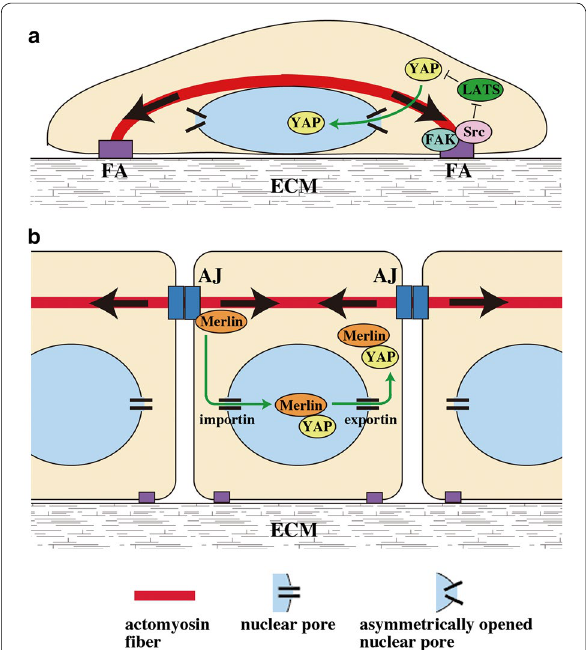
Fig. 4 Hypothetical models for actomyosin-dependent regulation of YAP nuclear localization in sparse and confluent cells. a Sparse cells develop FAs that are connected to actomyosin stress fibers. Tensile force exertion from stress fibers to FAs activates the FAK–Src signal, which inhibits LATS1/2-mediated phosphorylation of YAP, thereby facilitating nuclear translocation of YAP. In addition, contraction of stress fibers connecting FAs and the apical surface of the nucleus (sometimes called ‘actin cap’) flattens the nucleus, increases the curvature of the lateral part of the nuclear membrane, and thereby enlarges the diameter of the cytoplasmic side of the nuclear pore in this nuclear membrane part. Such ‘asymmetric opening’ of nuclear pores may preferentially promote nuclear import, rather than export, of YAP. b Confluent cells are poor in FAs and stress fibers, but instead develop AJs and actomyosin fibers associated with AJs. Actomyosin-based tensile force at AJs induces translocation of Merlin from AJs to the nucleus, wherein Merlin forms a complex with YAP. With the aid of nuclear export signals of Merlin, the Merlin-YAP complex is then exported from the nucleus. Thus the actomyosin activity has opposing effects on the YAP distribution between sparse and confluent cells; the actomyosin activity promotes nuclear localization of YAP in sparse cells, but attenuates it in confluent cells. See detailed discussion in the main